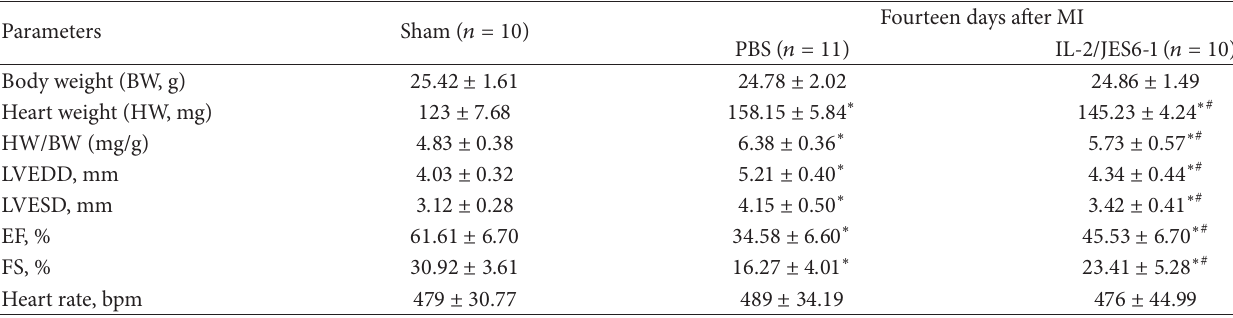
Table 1: Characteristics of mice at 2 weeks after Sham or MI